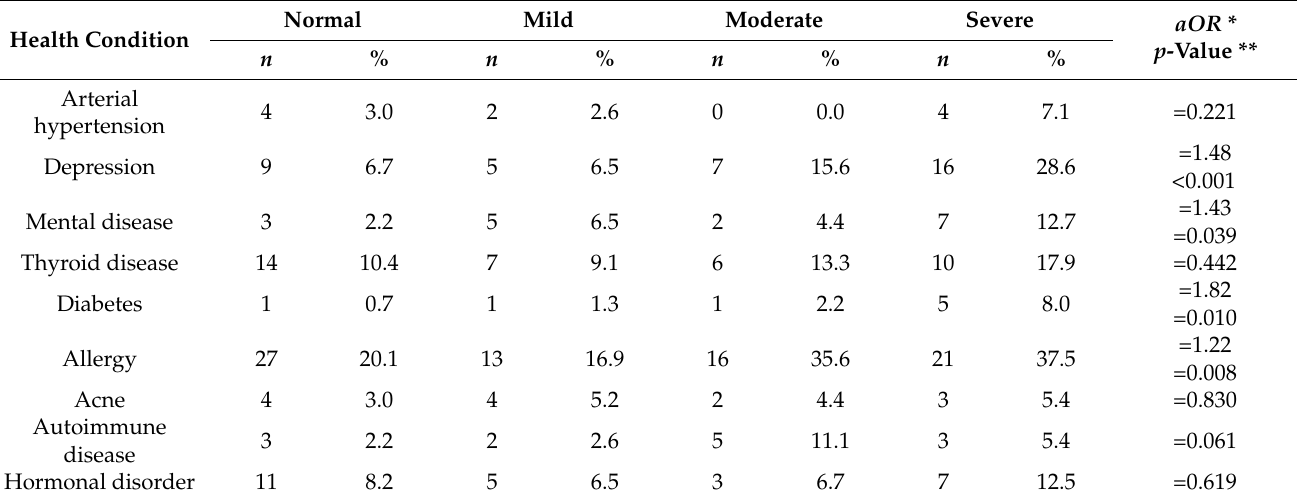
Multifactor analysis showed that the greatest influence on the higher score both in the OSDI and DEQ-5 was stress level (respectively p = 0.012 and p = 0.009). Mental diseases were proven to be a significant factor in the OSDI multifactor analysis ( p = 0.038), while in the DEQ-5 multifactor analysis, other factors showed to be significant were gender ( p = 0.020) and place of residence ( p = 0.046).